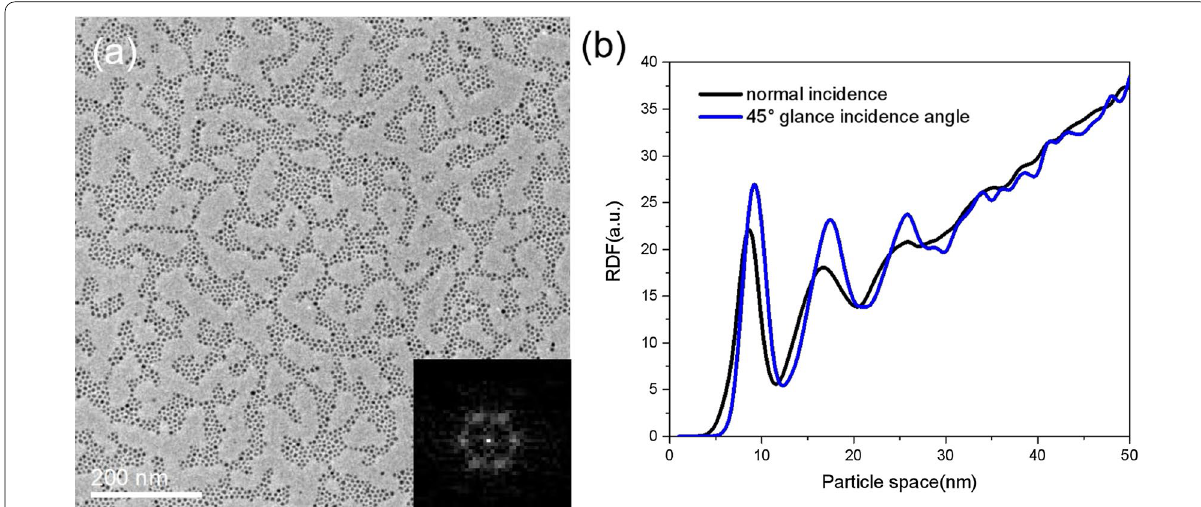
Fig. 5 a TEM image of Fe nanoparticle arrays deposited with a 45° glance incidence angle. The inset shows an FFT of the image. b A comparison of the RDFs of the Fe nanoparticle arrays deposited with a normal incidence and a 45° glance